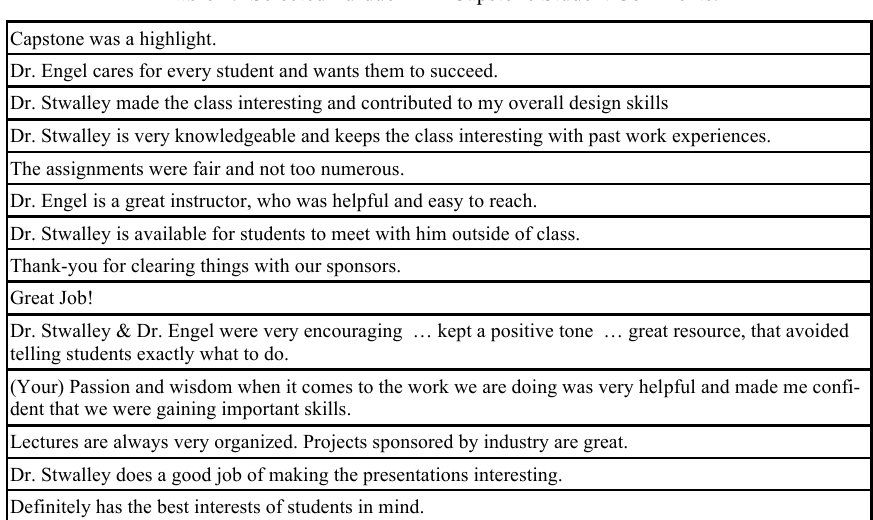
Table 1. Selected Purdue ABE Capstone Student